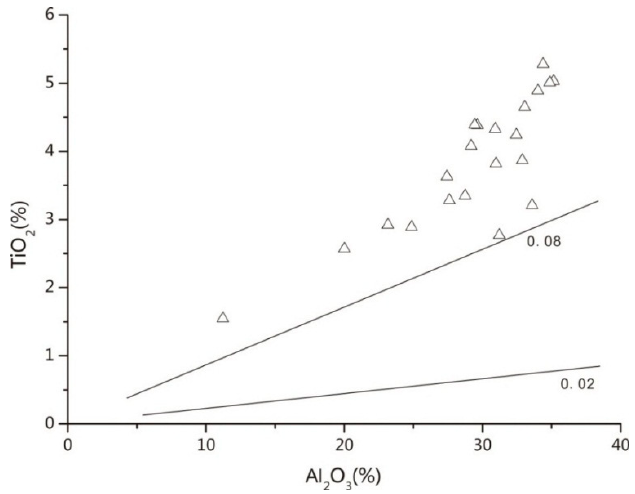
Figure 8. Plot for TiO 2 vs. Al 2 O 3 of tuff samples in the Zhongliangshan mine, Chongqing.